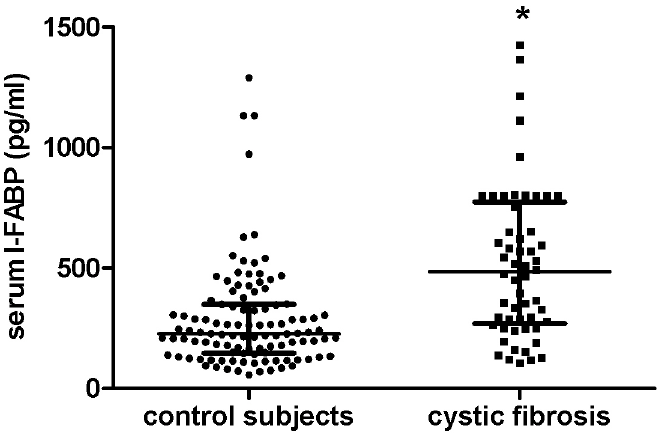
Fig 1. Serum I-FABP levels were significantly elevated in cystic fibrosis patients as compared with control subjects. Boxplot of serum I-FABP concentrations in the study groups, showing the median, the 25 th percentile, the 75 th percentile and the range of values. * Significant difference, p < 0.001.